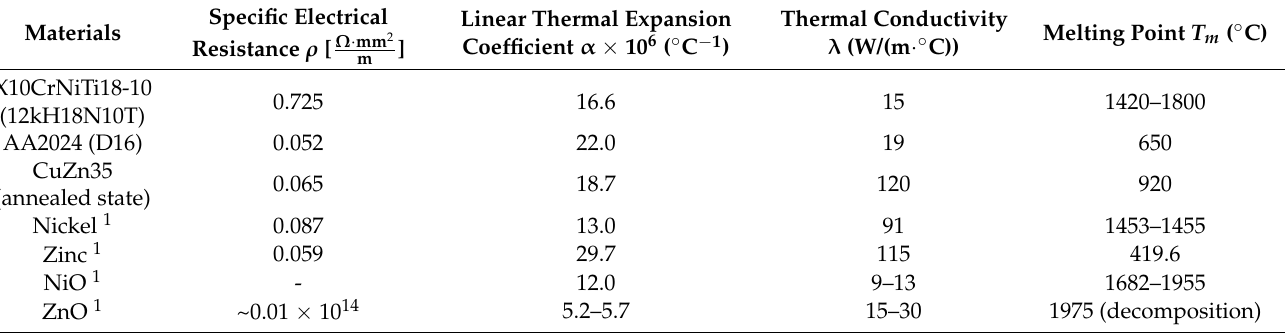
Table 5. Some electrical and physical properties of the